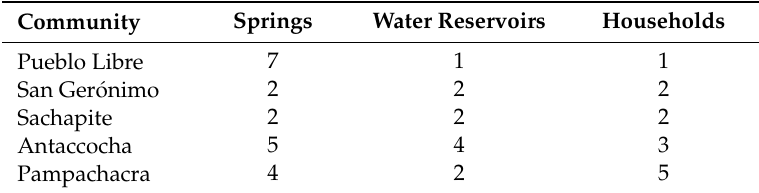
Table 1. Number of sampling points per